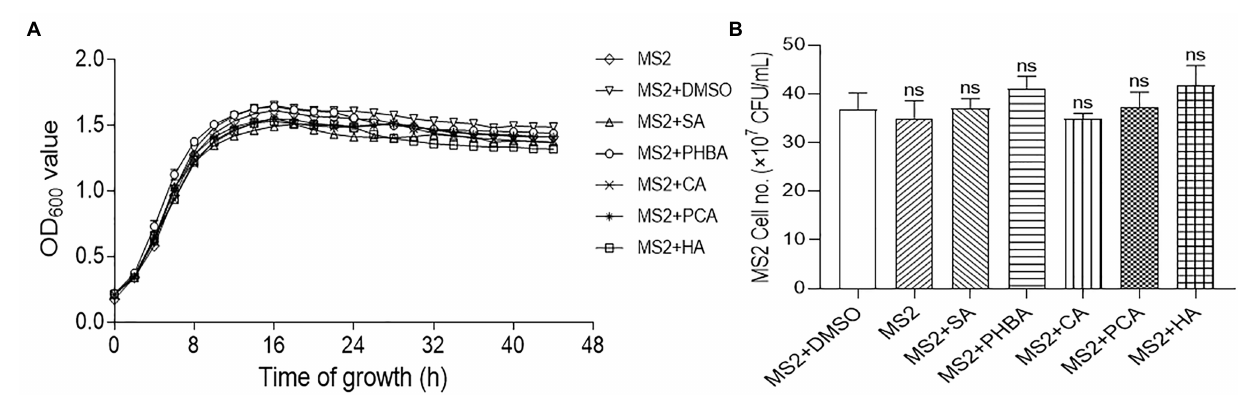
FIGURE 2 | Effects of SA (0.15 mM), PHBA (0.4 mM), CA (0.2 mM), PCA (0.2 mM), and HA (0.5 mM) on the growth of MS2 in LS5. (A) The growth curves of MS2 in LS5 supplemented with DMSO or tested compounds, respectively. MS2 culture (OD 600 of 2.0) was transferred into LS5 medium supplemented with candidate concentrations of tested compounds at a ratio of 1:10, and then dispended into a 96 well-tissue culture plate (200 μ l per well). Optical density (OD 600 ) of bacterial cultures was recorded every 2 h during a 44-h period using a Bioscreen automatic growth curve analyzer. Each point indicates the average value of three replicates with error bars representing the SD. (B) Colony forming units (CFU) of MS2 at 14 h of growth in LS5 supplemented with DMSO or tested compounds, respectively. Bacterial suspensions were diluted in gradient, 100 μ l of which was spread on LB agar plate and cultured at 28 ° C for 24 h. Plates with colony numbers between 30 and 300 were selected to count the CFU. MS2 + DMSO was used as the positive control. The data were the mean of three replicates and subjected to Student’s t -test analysis by Graphpad Prism 8.4.3 (ns, no statistical significance).